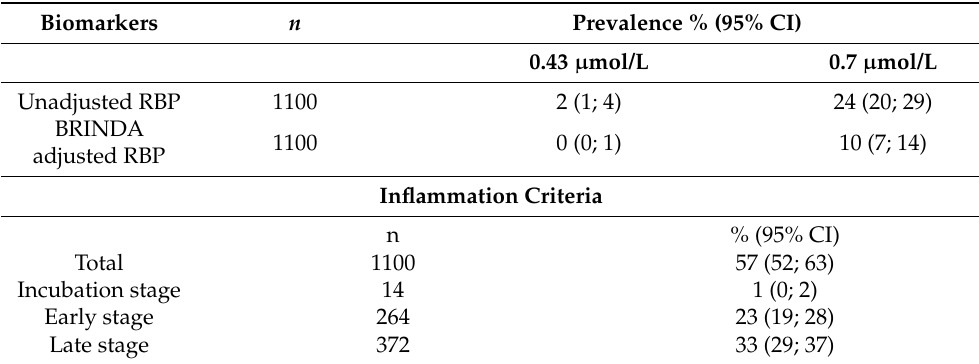
Table 4. Point estimates of vitamin A deficiency assessed using retinol-binding protein and inflam- mation assessed using C-reactive protein and Alpha-1-acid